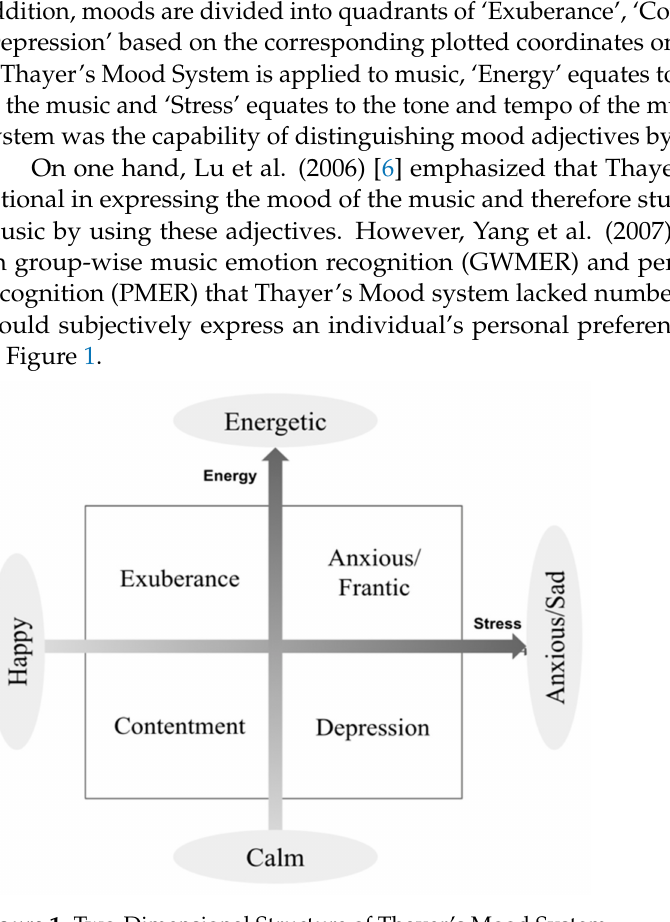
Figure 1. Two-Dimensional Structure of Thayer’s Mood